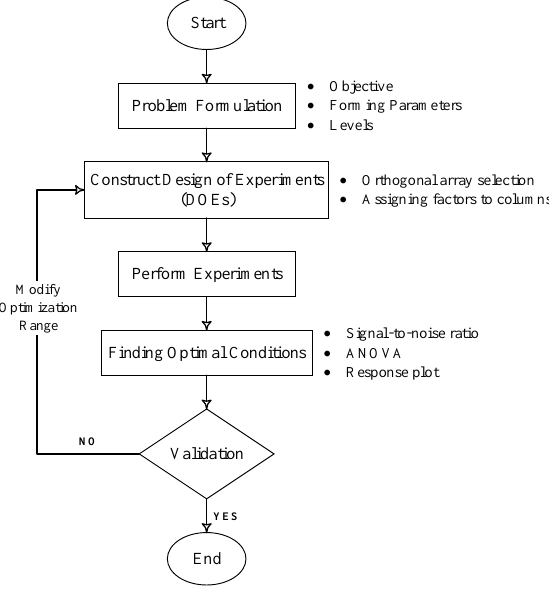
Figure 4. Flow chart illustrating Taguchi method procedures.